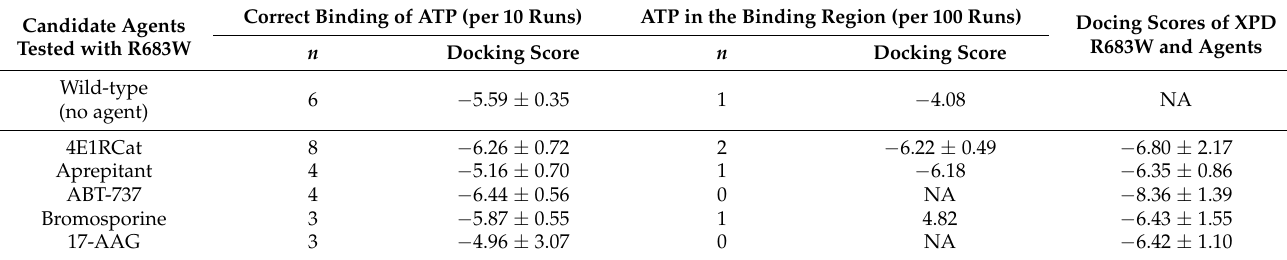
Figure 3. Validation of structural optimization. ( a , d ) The RMSD for the backbone atoms of XPD R683W with 4E1RCat ( a ) or aprepitant ( d ). ( b , e ) Cartoon representations of 3D structures of XPD R683W with 4E1RCat ( b ) or aprepitant ( e ). Blue areas indicate DNA-binding regions and green stick models indicate 4E1RCat ( b ) or aprepitant ( e ). ATP-binding regions are at opposite sides of these pictures. ( c , f ) Ramachandran plots for XPD R683W with 4E1RCat ( c ) or aprepitant ( f ). ( g ) Plot statistics for each complex of XPD R683W with the drug candidates. Table 1. Results of docking simulation analyses of XPD R683W with candidate agents, and ATP docking to induced-fit XPD R683W.